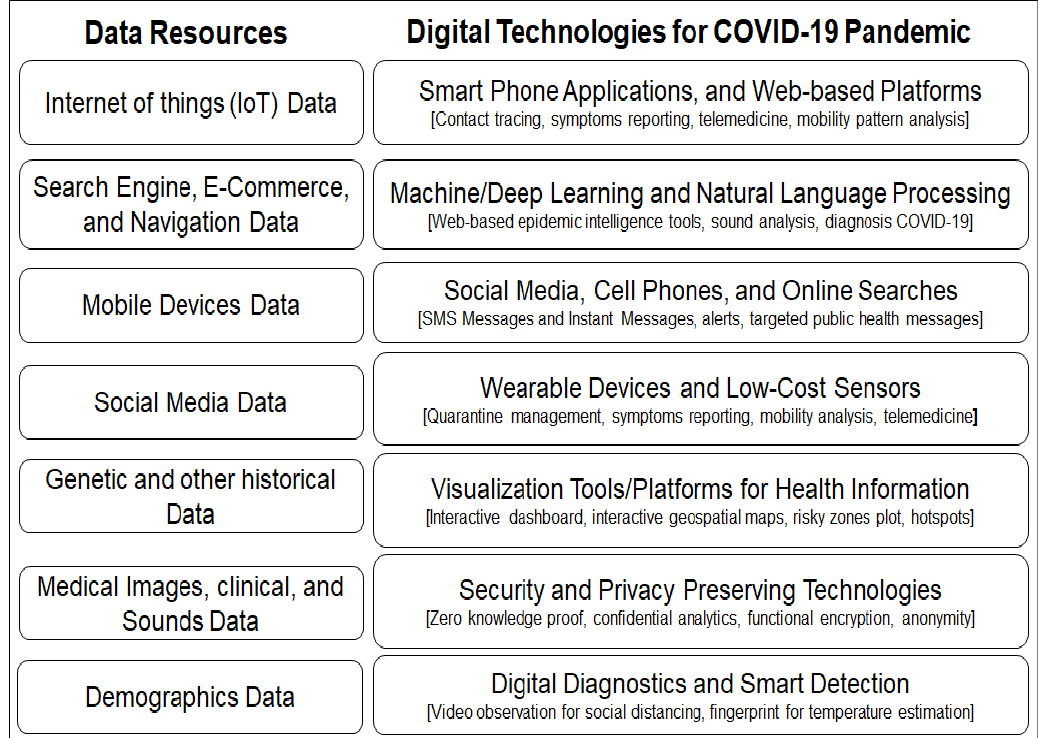
Figure 17. Overview of data sources and digital technologies that were employed to fight the